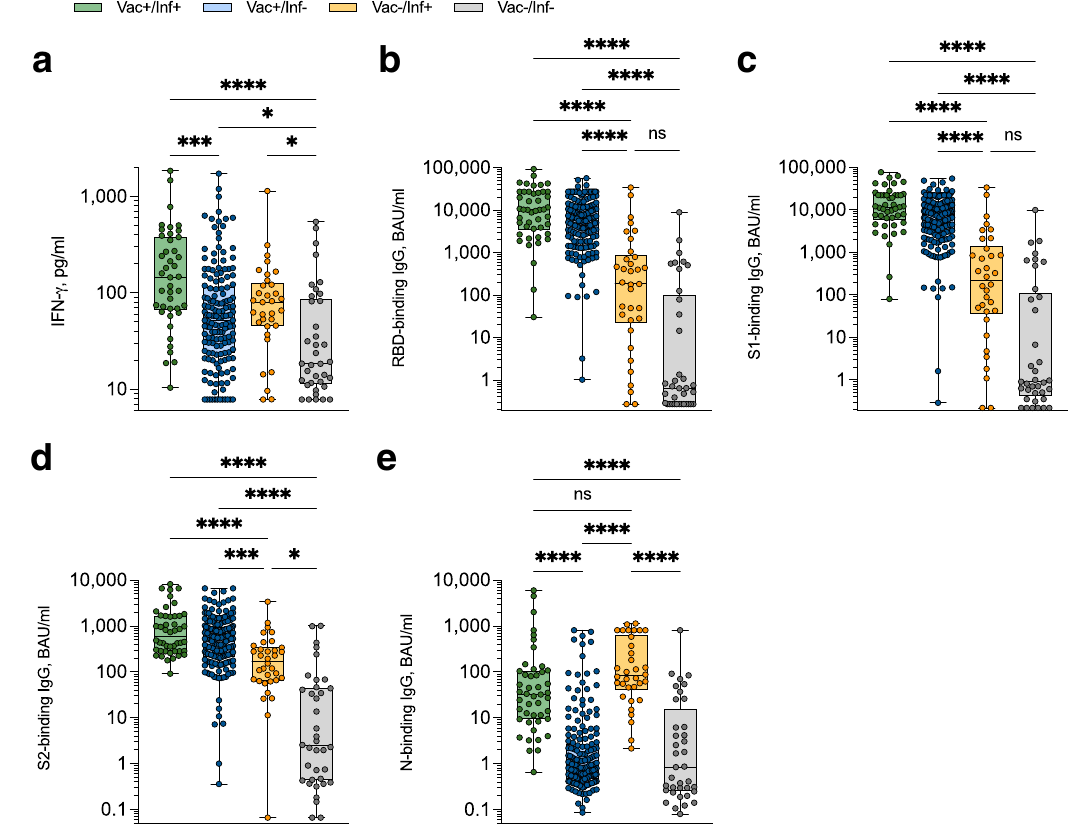
Fig. 3 | Magnitude of anti-SARS-CoV-2 T cell and IgG responses measured in capillary blood samples. a SARS-CoV-2-speci fi c IFN- γ + T cell responses were measured using the capillary whole blood assay and sub-divided based on parti- cipant vaccination and prior SARS-CoV-2 (PCR and/or lateral fl ow test con fi rmed) infection status. ‘ Vac+/Inf+ ’ n =42 (green), ‘ Vac+/Inf- ’ n =158 (blue), ‘ Vac-/Inf+ ’ n =33(yellow), ‘ Vac-/Inf- ’ n =37(grey). **** P <0.0001, *** P =0.0001, *(Vac+/Inf-vs. Vac-/Inf-) P =0.045, *(Vac-/Inf+ vs. Vac-/Inf-) P =0.014. SARS-CoV-2-speci fi c IgG- binding responses targeting spike receptor binding domain ( ‘ RBD ’ ) ( b ; **** P <0.0001, ns: not signi fi cant), spike subunit 1 ( ‘ S1 ’ ) ( c ; **** P <0.0001, ns: not signi fi cant), spike subunit 2 ( ‘ S2 ’ ) ( d ; **** P <0.0001, *** P =0.0005, * P =0.016) and